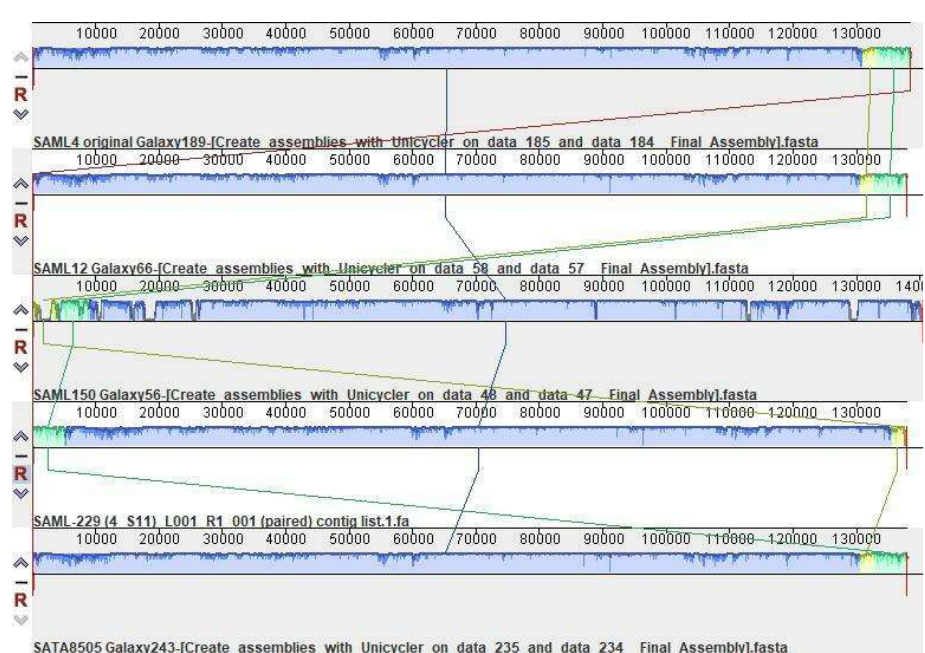
Figure 1. Mauve comparative genomic sequence analysis of the five S. aureus phages included in StaphLyse™. This method aligns conserved regions in two or more genomes. The genomes of the five StaphLyse™ phages are lined up parallel to each other. The red vertical lines indicate the ge- nome boundaries, which were determined using the genome assembly tool (defined by long termi- nal repeats, which are typical of the Herelleviridae family). Colored similarity plots are shown for each genome. Different colors represent different conserved regions within the genome. These re- gions are referred to as locally collinear blocks (LCBs). Similar colors with connecting lines show which regions are similar between the genomes. Shading and spacing within the LCB depict varia- tion. In this figure, there are three LCBs, shown as blue, yellow, and green, shared among the five phage genomes [50].